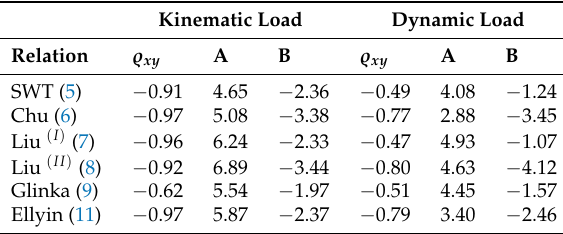
Table 6. The correlation coefficient (cid:36) xy and the regression curve of Equation (16) for parameters A , B . Kinematic